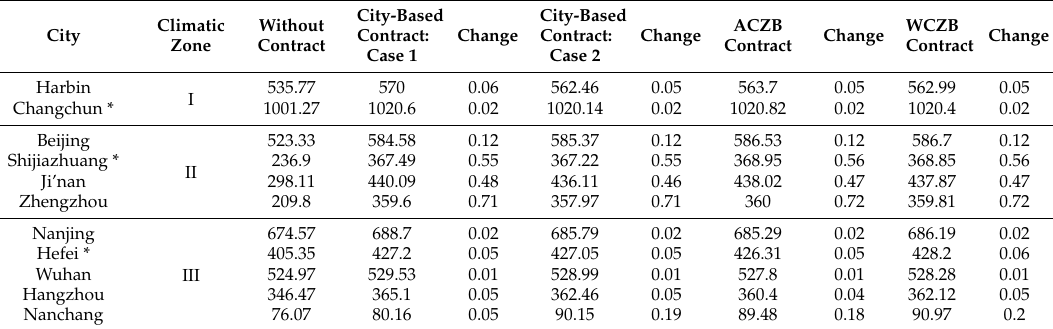
Table 6. Efficiency comparison among city-based GDD contracts, ACZB contracts and WCZB contracts: certainty-equivalent revenue